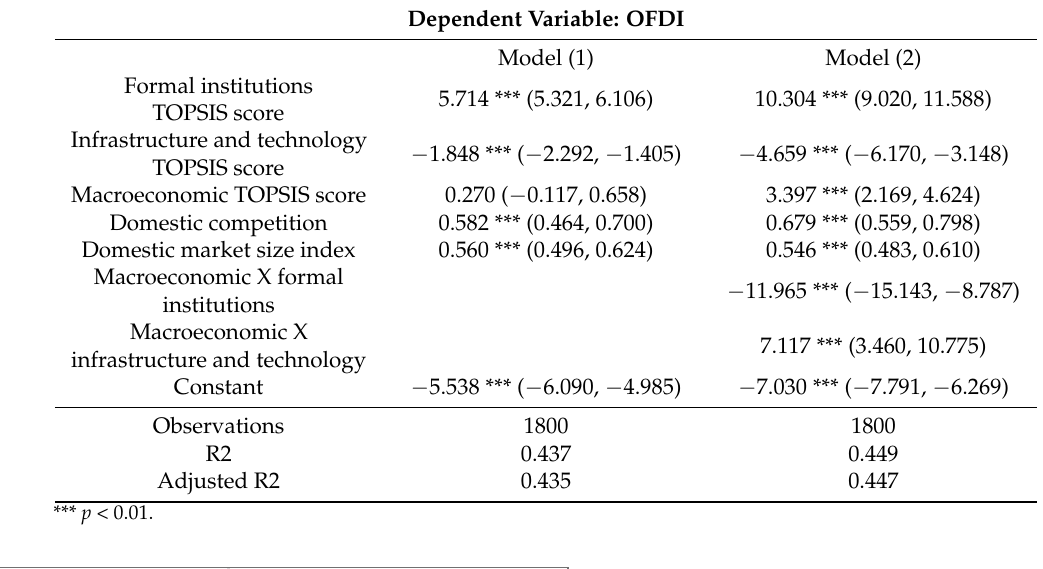
Table 5. The regression outputs summary and comparison for the models considered, in terms of model coefficients, their associated 95% confidence intervals, significancy of coefficients, and level of predictive power of the models.